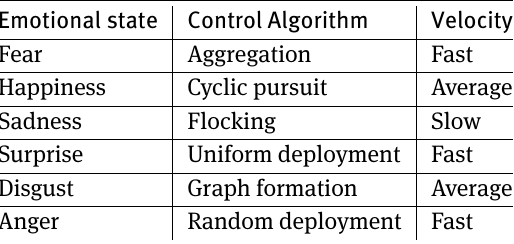
able online¹. Table 4: The six expressive motions designed based on the control algorithms defined in Section 3.2 and the setpoint velocity of the